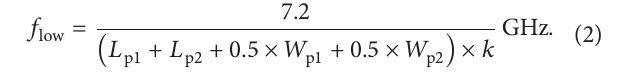
plane parasitic resonator led to a good matching at the lower band and lowered its resonant frequency. The higher band is further lowered due to the increased loading effects of the ground